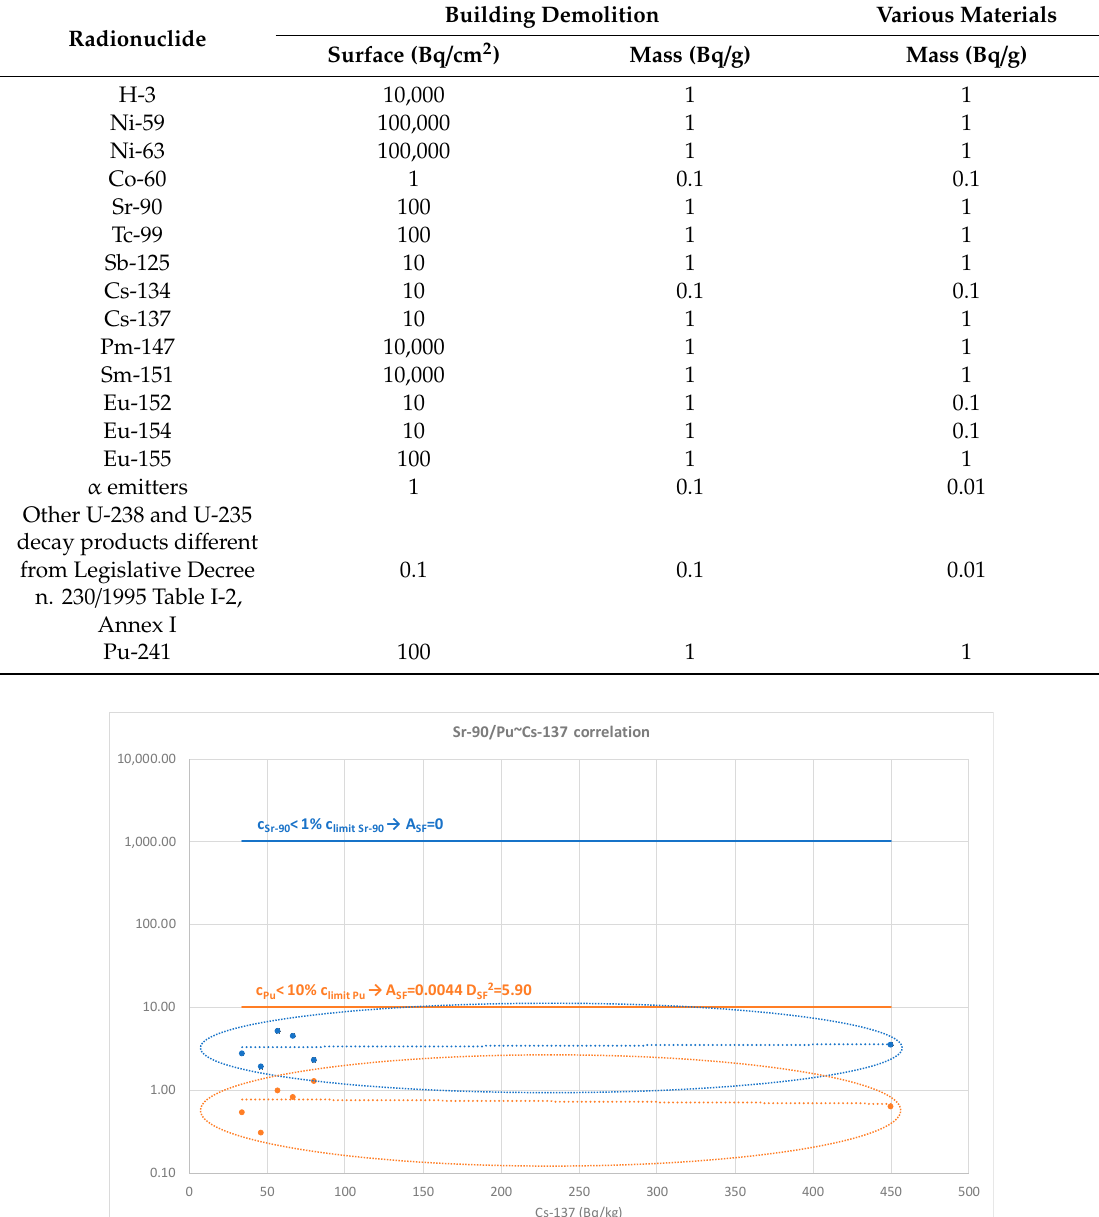
Table 5. Cementitious and various materials clearance levels. Ministerial Decree 12 August 2009.